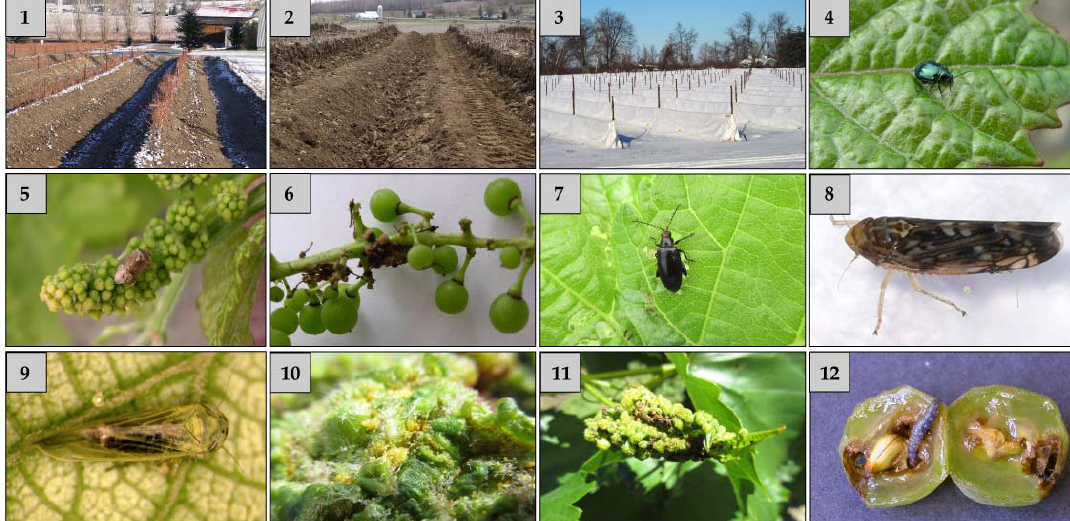
Figure 1: (1) Hilling soil to cover trunk and canes in autumn (J. Lasnier); (2) Unearthing vines in the spring (J. Lasnier); (3) Winter frost protection with geotextile (J. Lasnier). (4) Adult grape flea beetle, Altica woodsi (Chrysomelidae)(J. Lasnier); (5) Tarnished plant bug, Lygus lineolaris (Miridae) adult on cluster (J. Lasnier); (6) Tarnished plant bug damage on cluster (J. Lasnier); (7) Adult red ‐ headed flea beetle, Systena frontalis (J. Lasnier); (8) American grapevine leafhopper, Scaphoideus titanus (Cicadellidae) (I. Loser); (9) Adult six ‐ spotted leafhopper, Macrolestes quadrilineatus (Cicadellidae), aster yellow vector (J. Saguez); (10) Grape phylloxera, Daktulosphaira vitifoliae (Phylloxeridae) eggs, nymphs and adults in a gall (J. Lasnier); (11) Severe Grape phylloxera infestation of terminal shoots (J. Lasnier); (12) Grape berry moth, Paralobesia viteana (Tortricidae) larva on open berry (J. Lasnier).